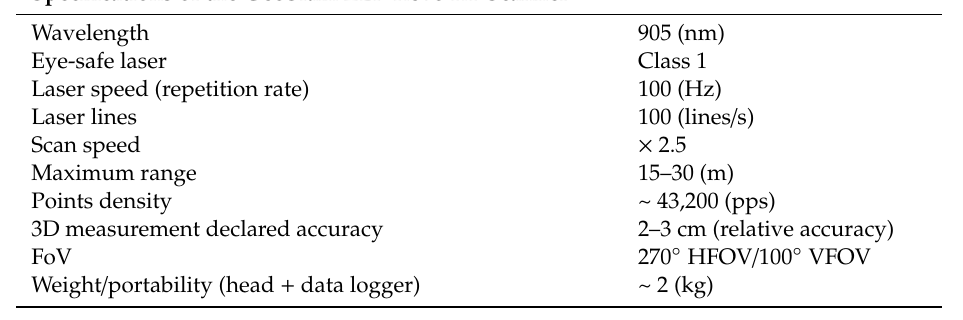
Table 4. Main specifications of the GeoSlam ZEB Revo RT platform used for the Mobile Mapping System (MMS) survey.